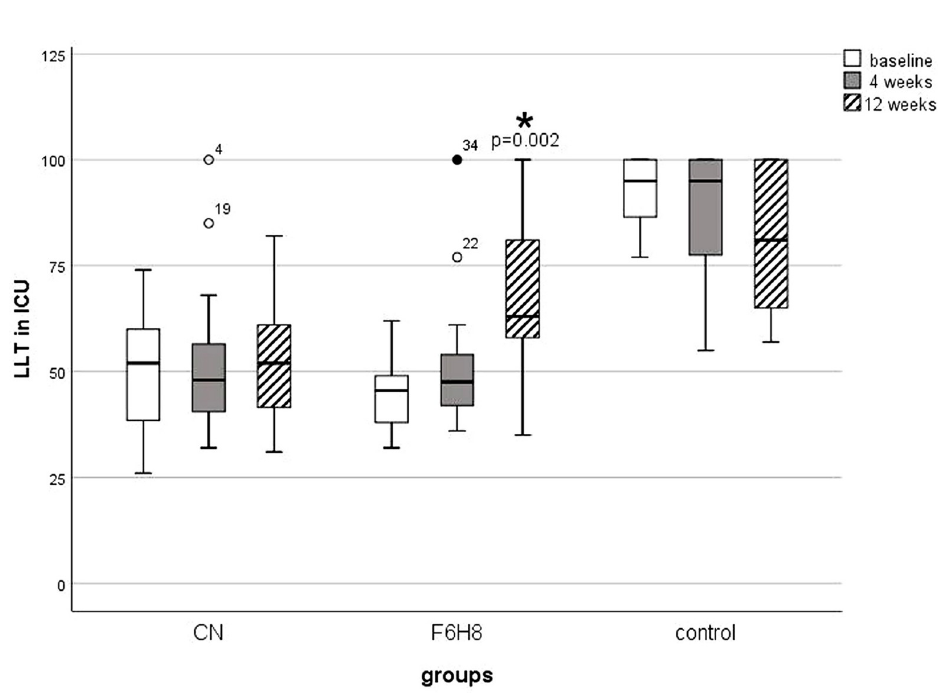
Fig 4. Lipid layer thickness (in ICU) at consecutive measurements. The LLT at 4 and 12 weeks were compared to the LLTat baseline using the Wilcoxon test. All p-values were adjusted for 2 comparisons according to the Bonferroni method. An asterisk with the corresponding p-value indicates a significant change compared to the baseline. ICU = Interferometric Colour Units; CN = cationic nanoemulsion; F6H8 =